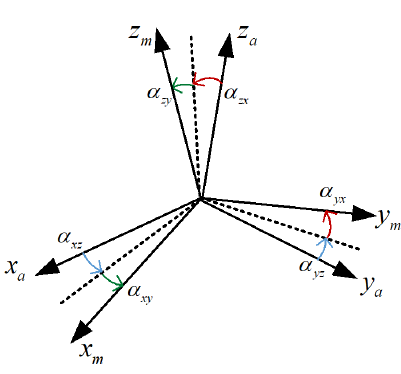
Figure 3. Accelerometer non-orthogonal coordinate